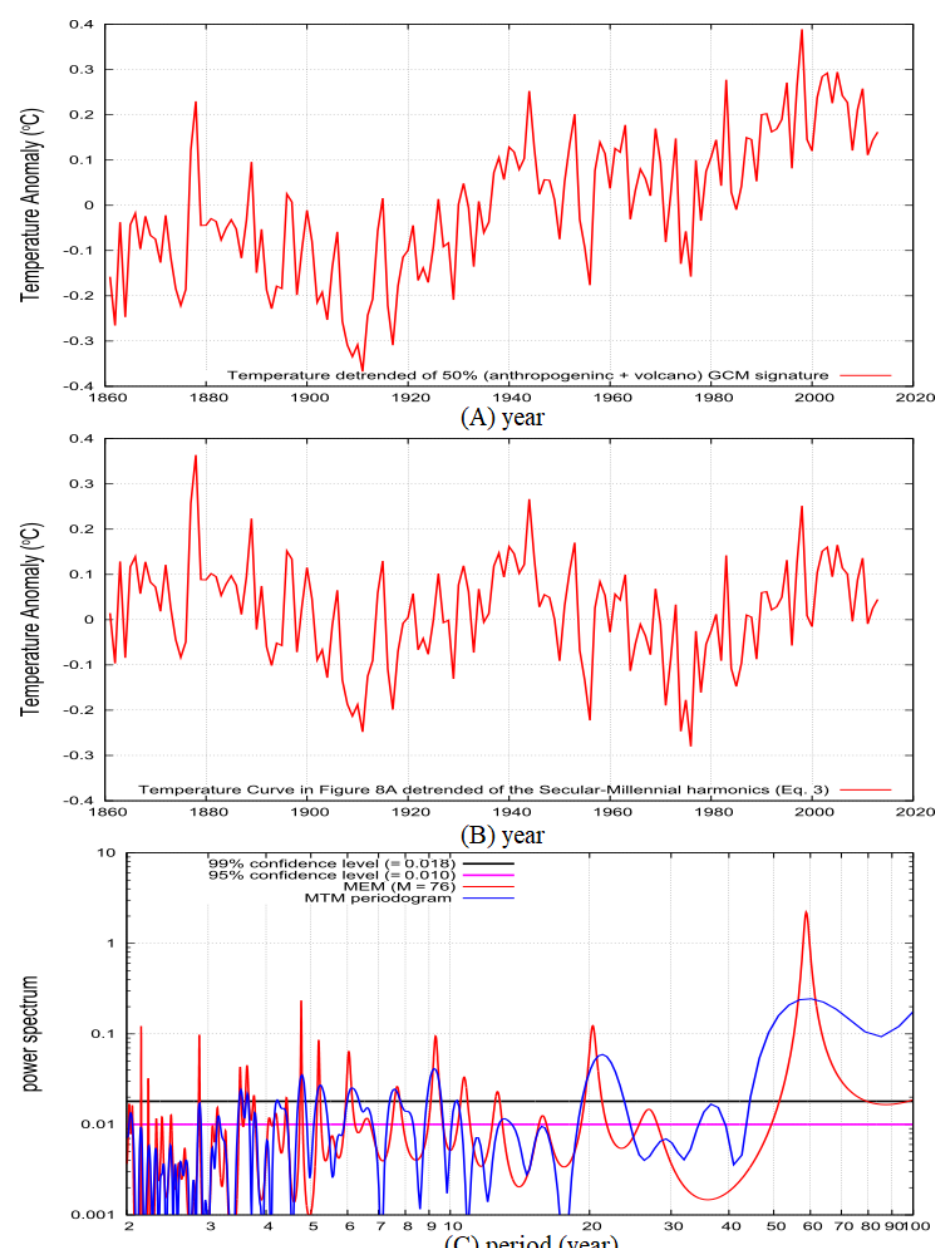
Figure 8. ( A ) HadCRUT4 detrended of 50% of the CMIP5 multi-model mean simulation relative to anthropogenic and volcanic forcings alone (blue curve in Figure 5), Equation (6). ( B ) Record depicted in A detrended of the secular and the millennial oscillations: see Equations (7) and (8). ( C ) MTM and MEM power spectra of the record depicted in